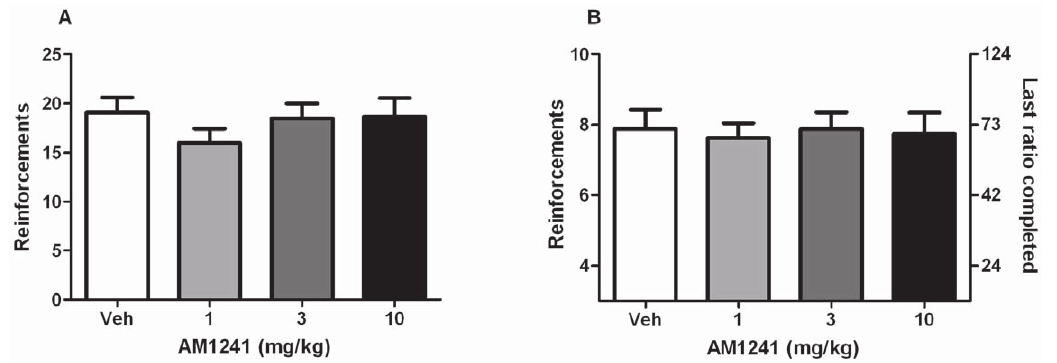
Figure 2. Effects of AM1241 on nicotine self-administration under FR5 and PR schedules of reinforcement. A . Effects of pretreatment with AM1241 (1, 3 and 10 mg/kg, IP H 30) on nicotine (30 m g/kg/infusion) self-administration under the FR5 schedule. Data are expressed as means ( 6 SEM) of the number of nicotine infusions obtained during the 60-min session. All doses of AM1241 did not affect responding vs. vehicle (0 mg/kg) pretreatment (N=10); P=0.35. B . Effects of pretreatment with AM1241 (1, 3 and 10 mg/kg) on nicotine (30 ug/kg/infusion) self- administration under PR schedule. A , Data are expressed as means ( 6 SEM) of the number of nicotine infusions obtained during the 4-hr sessions. AM1241 did not affect break point P . 0.05 compared to vehicle (0 mg/kg) pretreatment. (N=8) P=0.89.